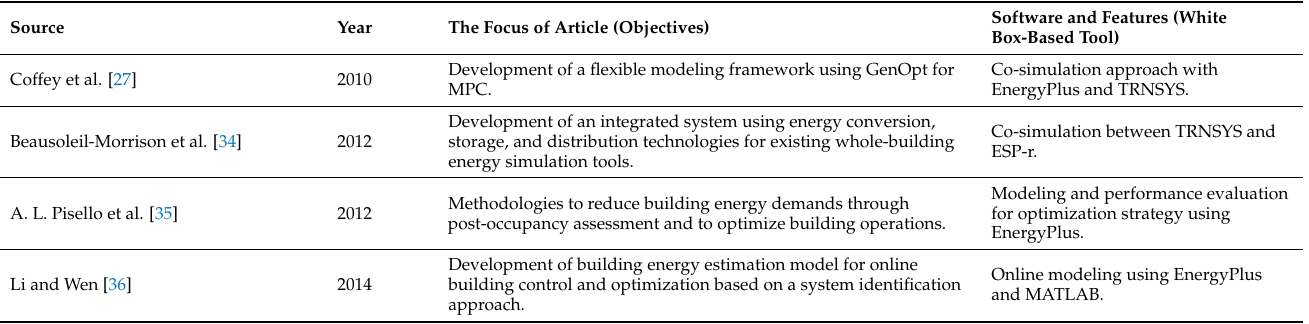
Table 1. List of the representative reviewed papers regarding “white-box” models for building energy simulation.